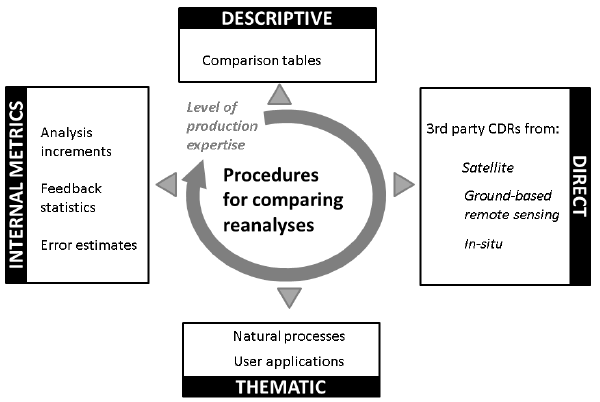
Figure 1. Useful approaches for intercomparing reanalyses include: (1) descriptive, e.g., a comparison table of characteristics, (2) direct comparisons with in-situ, ground-based remote sensing or satel- lite observations, (3) thematic comparison, and (4) internal metrics